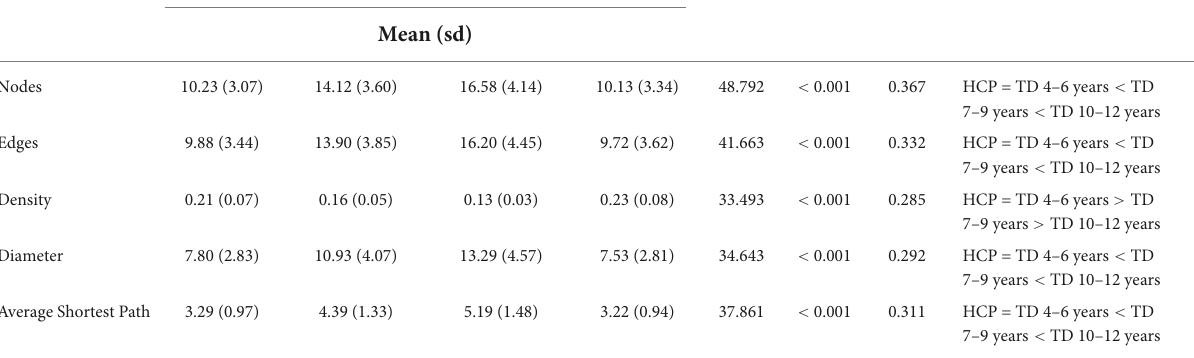
TABLE 3 Comparisons among groups in word fluency task (graph analysis of body parts category).